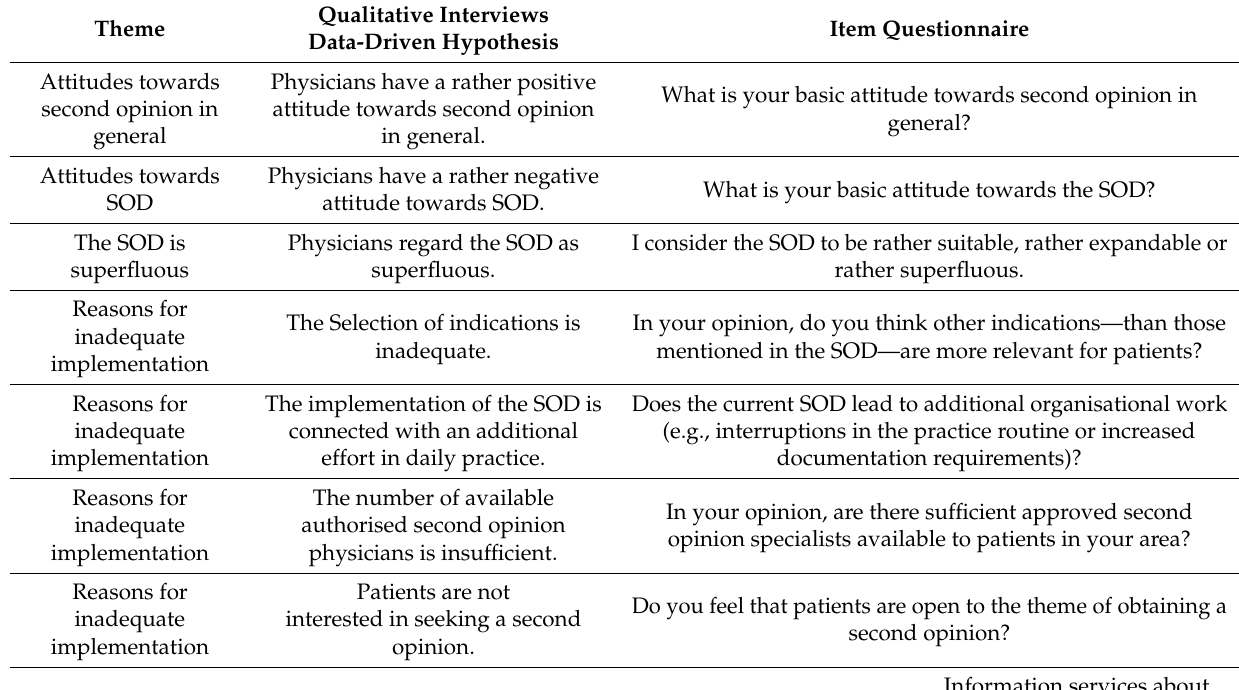
Table 3. Joint Display: Qualitative Data and Descriptive statistic of weighted participants’